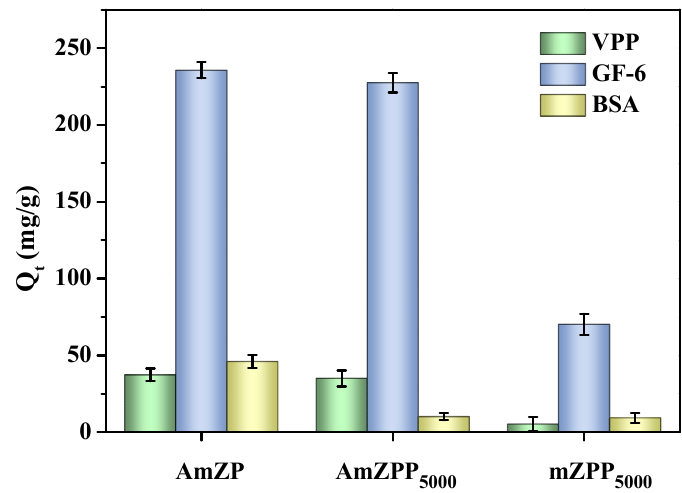
Figure 10. Adsorption data of AmZPP 5000 in mixed system.